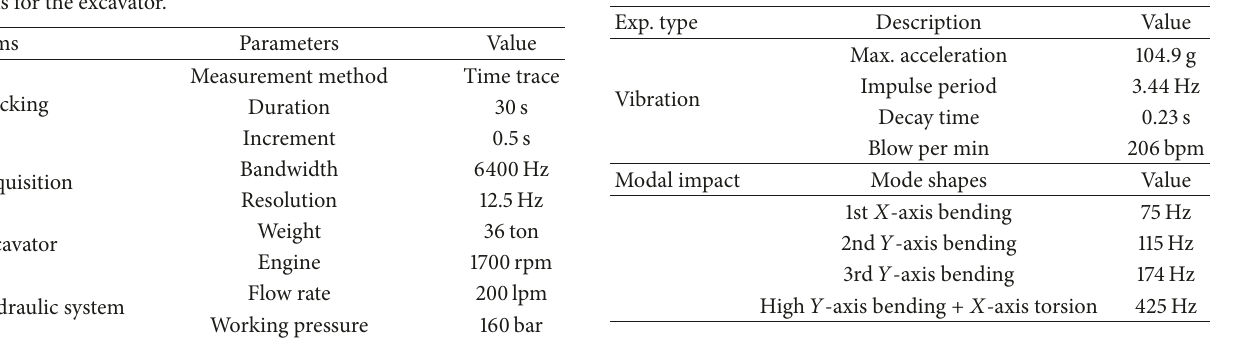
Table 2: Results of vibration and modal impact